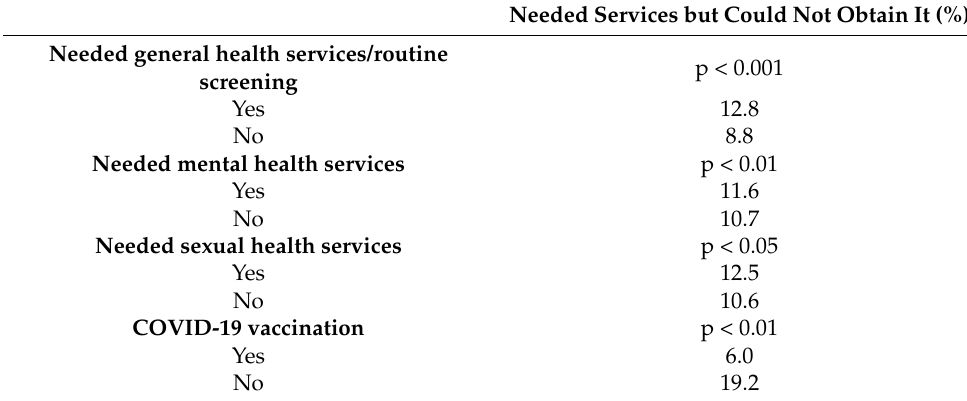
Table 3. Inability to obtain healthcare services by types of services.